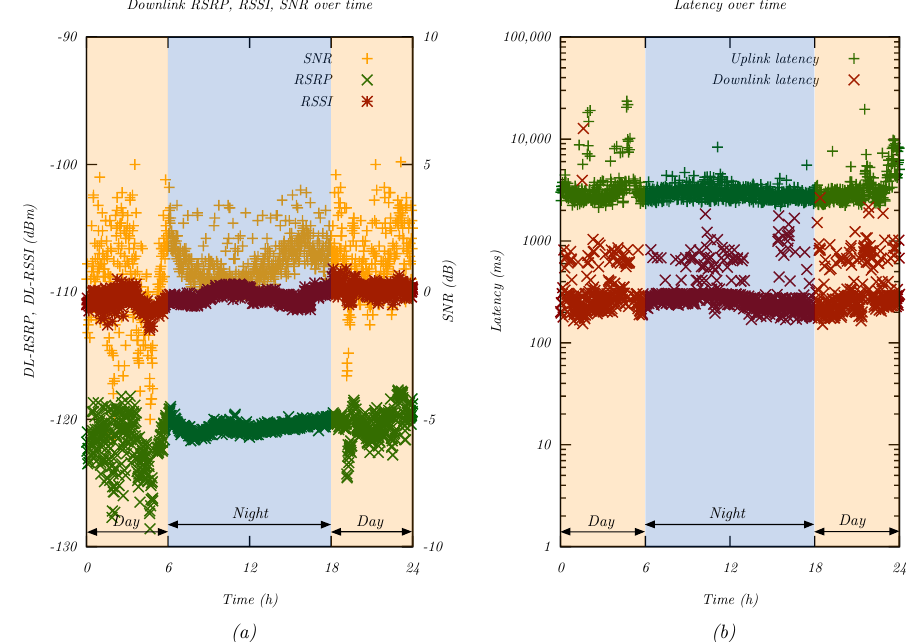
Figure 10. Long-term measurement of NB-IoT QoS parameters over a full day. ( a ) Signal quality parameters over one day. ( b ) Uplink and downlink latency over 24